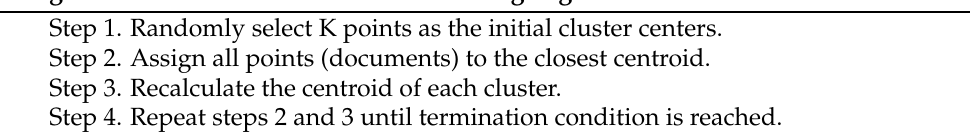
Algorithm 1: K-means Document Clustering